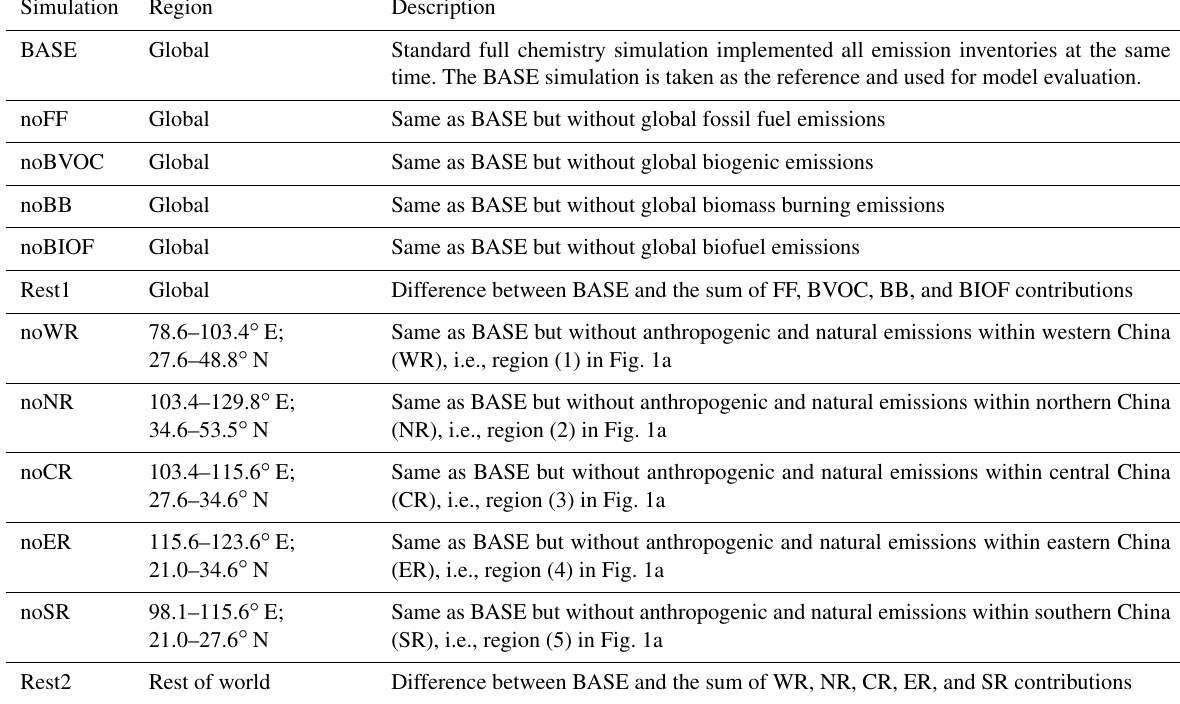
Table 3. GEOS-Chem model configurations and delimitations of all geographical regions. For all sensitivity simulations, the CH 4 emission inventory is always switched